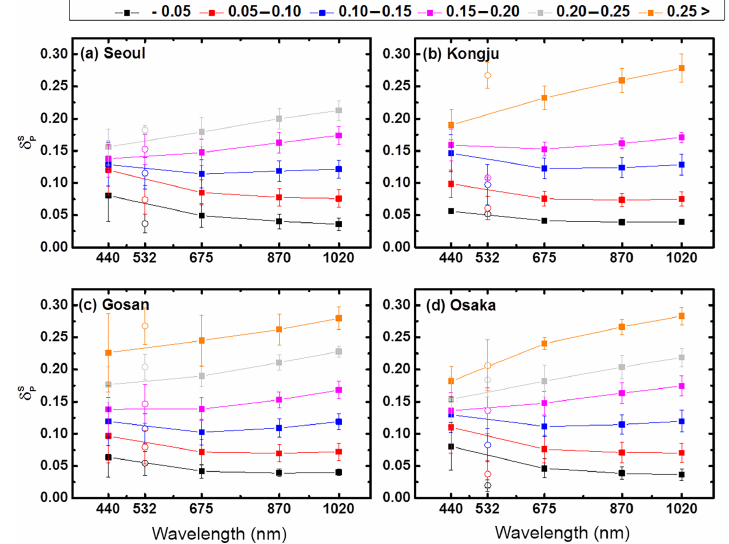
Figure 7. The average value of the δ S at 440, 675, 870, and 1020nm for each group. Each group is distinguished by color: black (group 1), P red (group 2), blue (group 3), pink (group 4), gray (group 5), and orange (group 6). The average values of the δ CL open circles and the same color as the values of δ S P